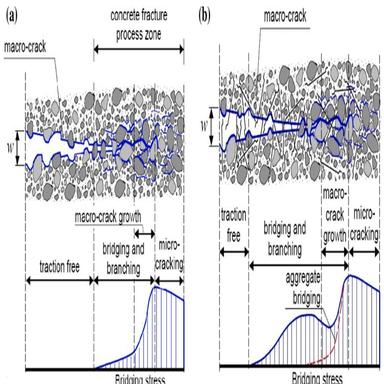
Schematic description of the stress-crack opening relationship for (a) conventional and (b) fibre-reinforced concrete, adapted from . Note: w is the crack width.